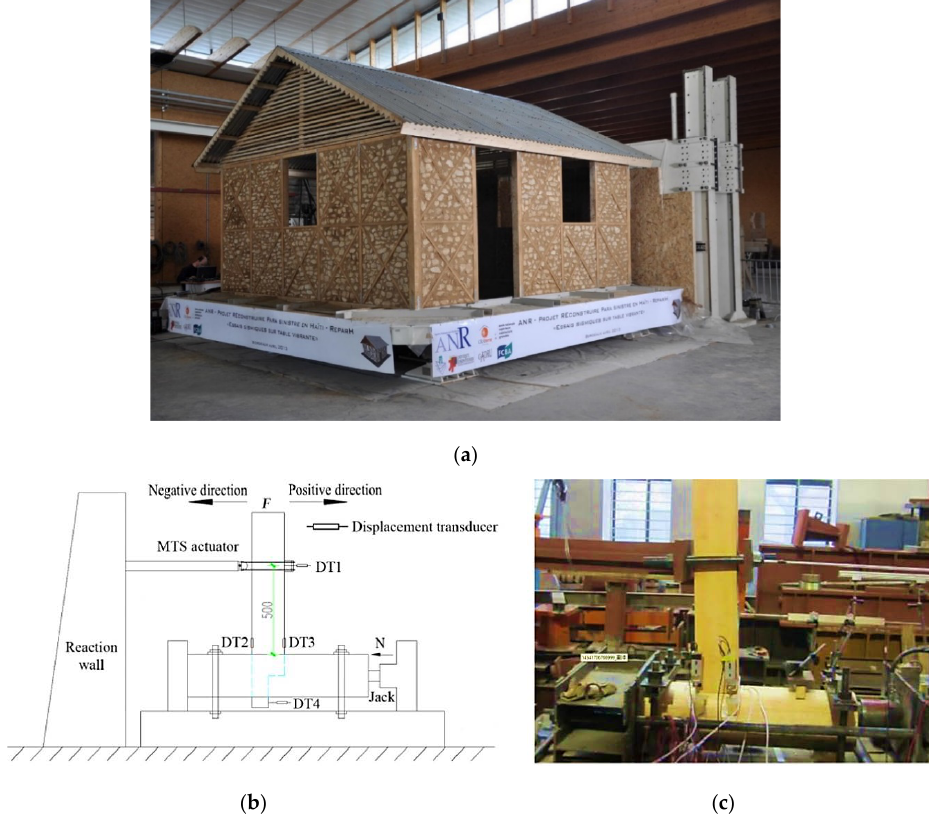
Figure 7. ( a ) A timber frame building on a shaking table reprinted from [89] ; ( b ) Schematic drawing; ( c ) Overview of the cyclic tests setup of a timber connection. Reprinted from [93].